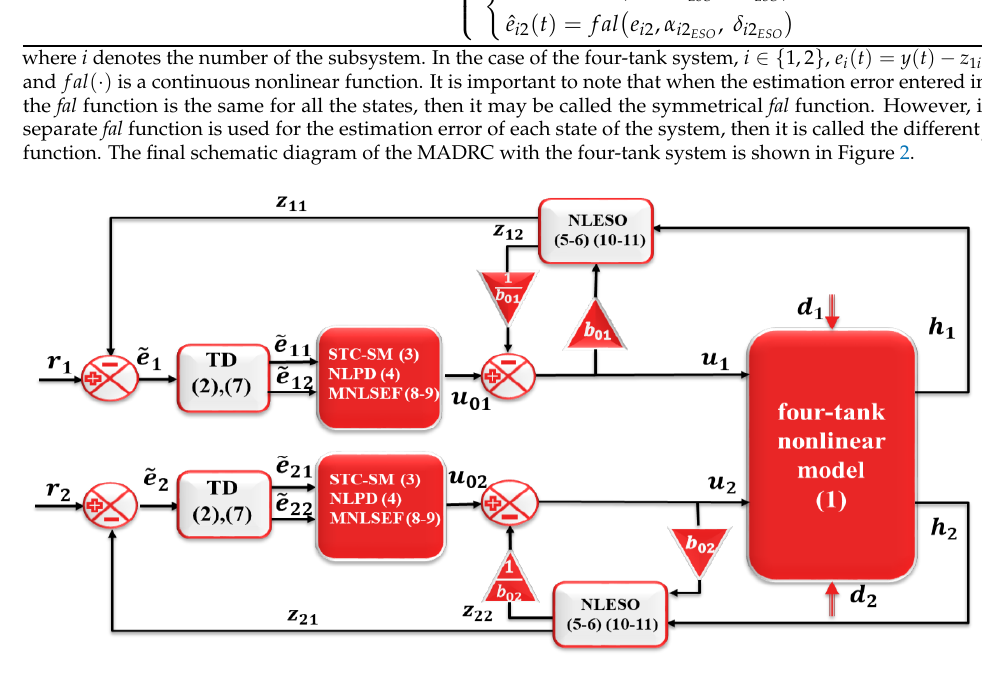
Figure 2. The complete MADRC four-tank system schematic diagram.